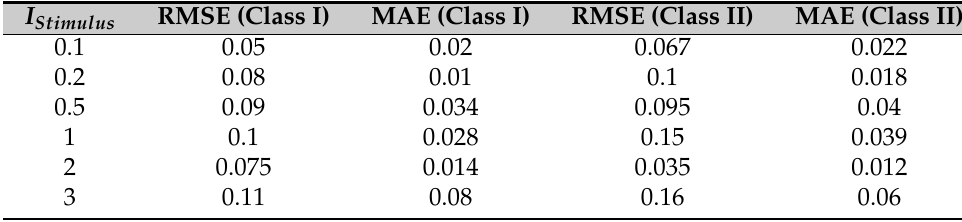
Table 4. Error Calculations of the Proposed